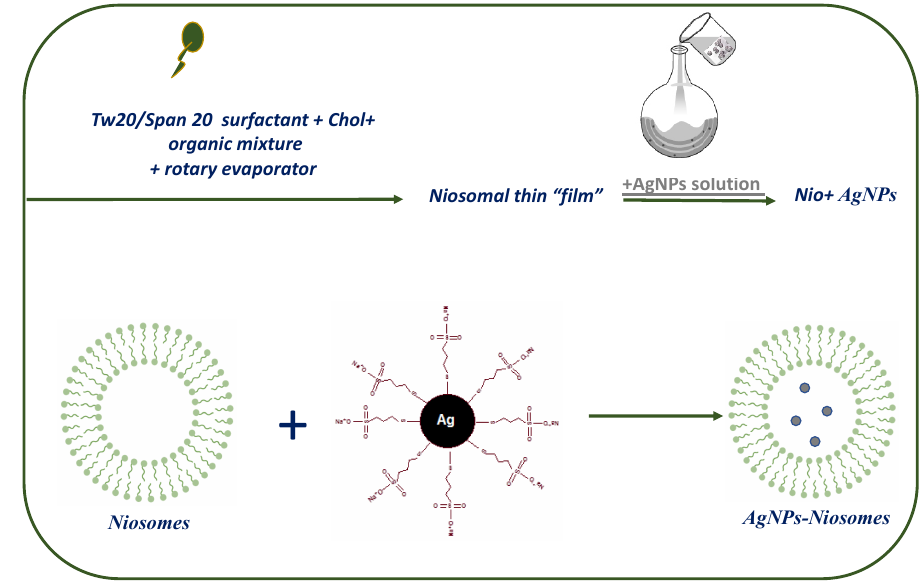
Figure 1. Preparation of niosomes hydrated with silver nanoparticles (Nio-AgNPs). According to characterization results obtained, the best samples selected were Tween 20/Span 20 niosomes hydrated with AgNPs at the 0.5 mg/mL concentration.